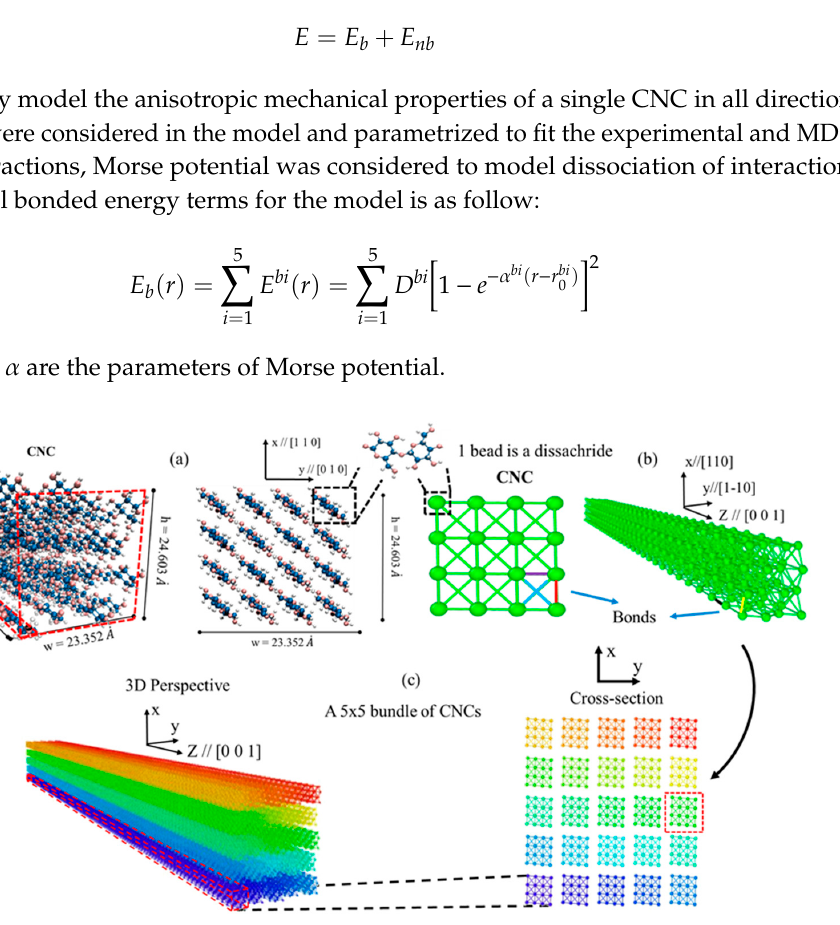
Figure 1. ( a ) 3D and cross-section view of the atomistic structure of cellulose nanocrystals (CNC) [1,40]. Pink spheres denote oxygen atoms, blue spheres represent carbon atoms, and white spheres are hydrogen atoms. ( b ) The coarse-grained (CG) model of CNC, where each bead represents a disaccharide and is connected with 5 different internal bonds is shown with different colors. ( c ) A 3D and cross-section view of a 5 × 5 CNC bundle, where different particles are shown with a different color.